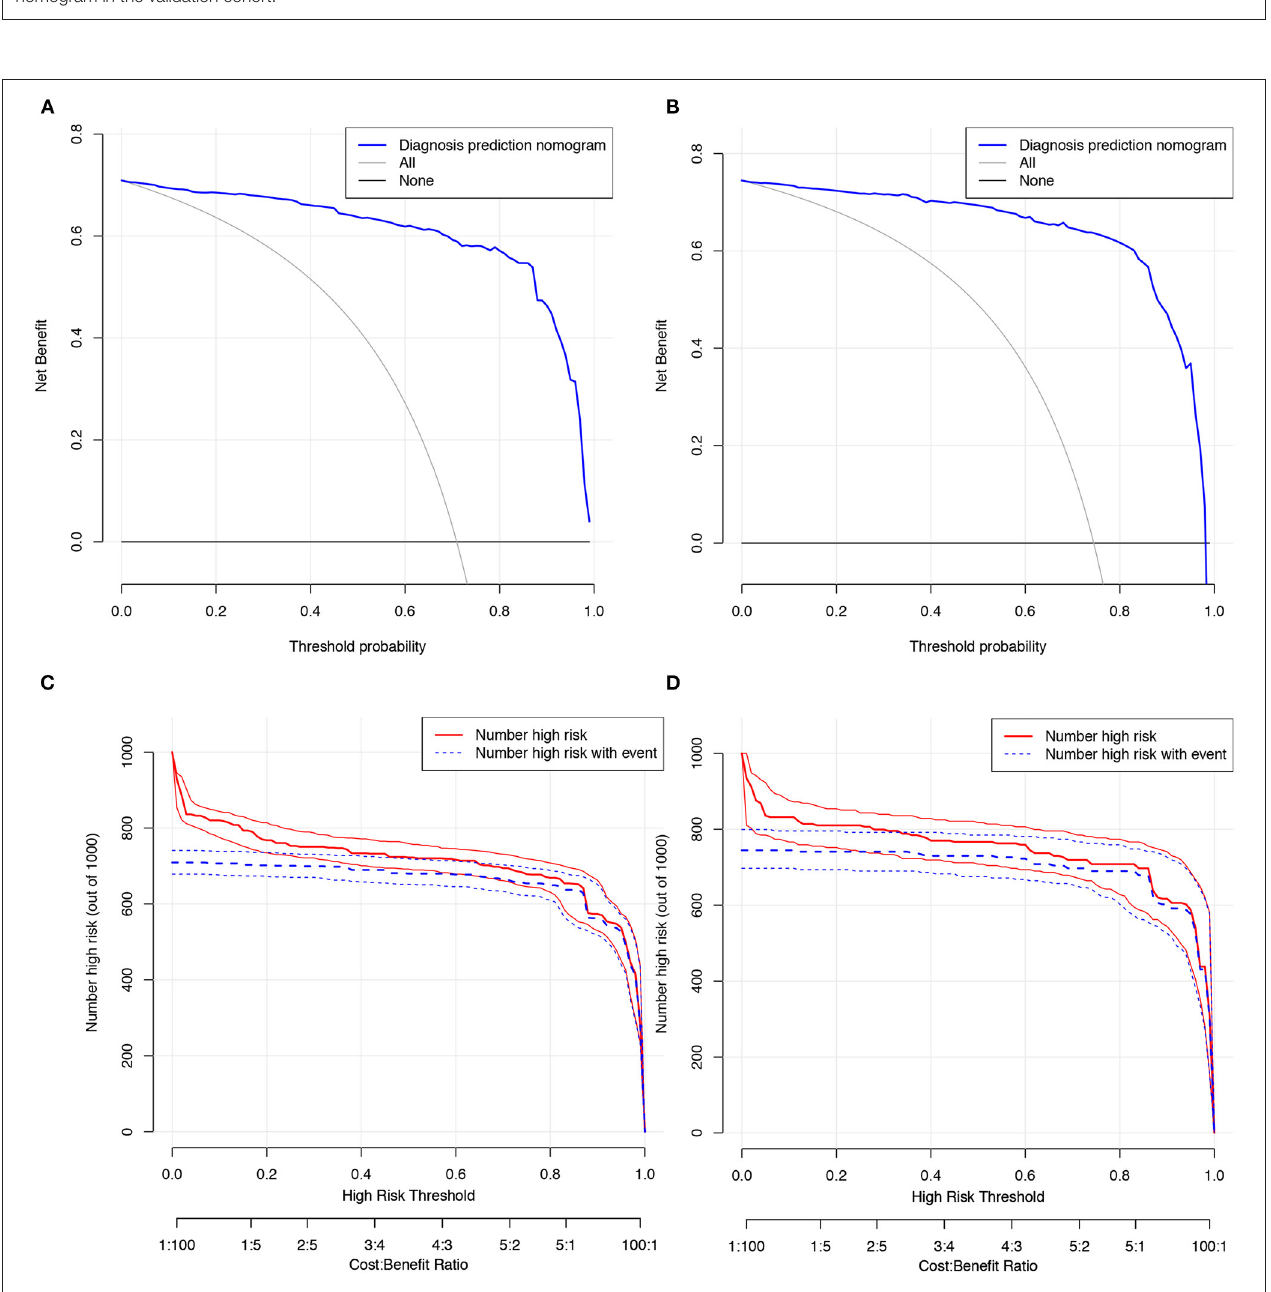
FIGURE 3 | each model in terms of the agreement between the predicted risks of COVID-19 and observed outcomes of a confirmed diagnosis of COVID-19. The Y-axis represents the actual COVID-19 rate. The X-axis represents the predicted COVID-19 risk. The diagonal dotted line represents a perfect prediction by an ideal model. The black solid line represents the performance of the CIAAD nomogram, of which a closer fit to the diagonal dotted line represents a better prediction. (C) . Calibration curve of the CIAAD nomogram in the validation cohort. (D) . ROC curve of the CIAAD nomogram in the training cohort. (E) . ROC curve of the CIAAD nomogram in the validation cohort.